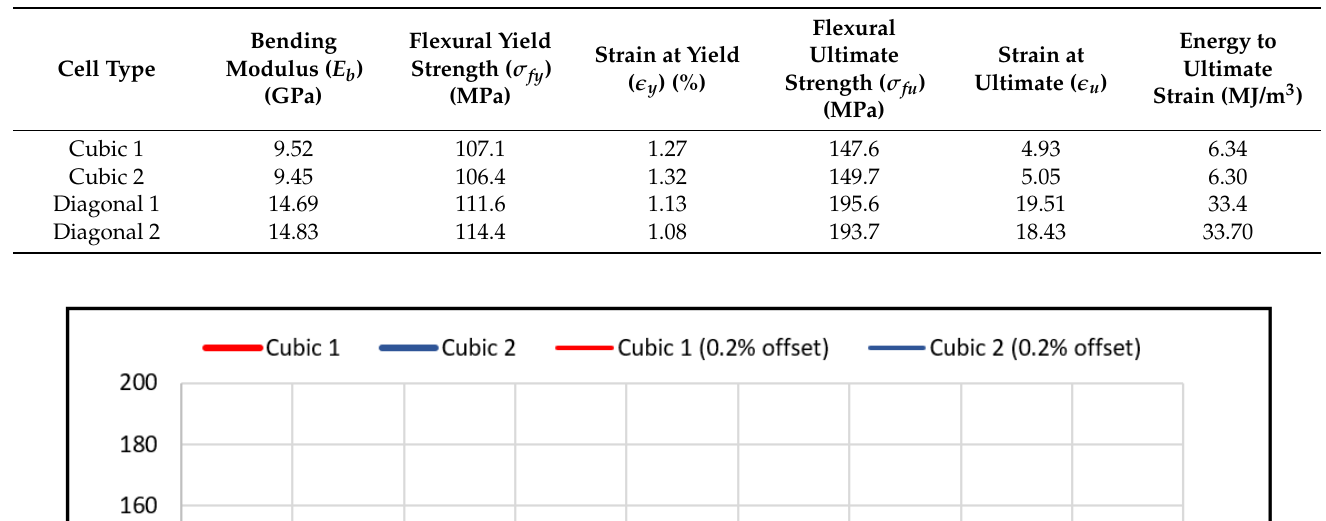
Table 5. Flexural properties of the cubic and diagonal scaffolds.